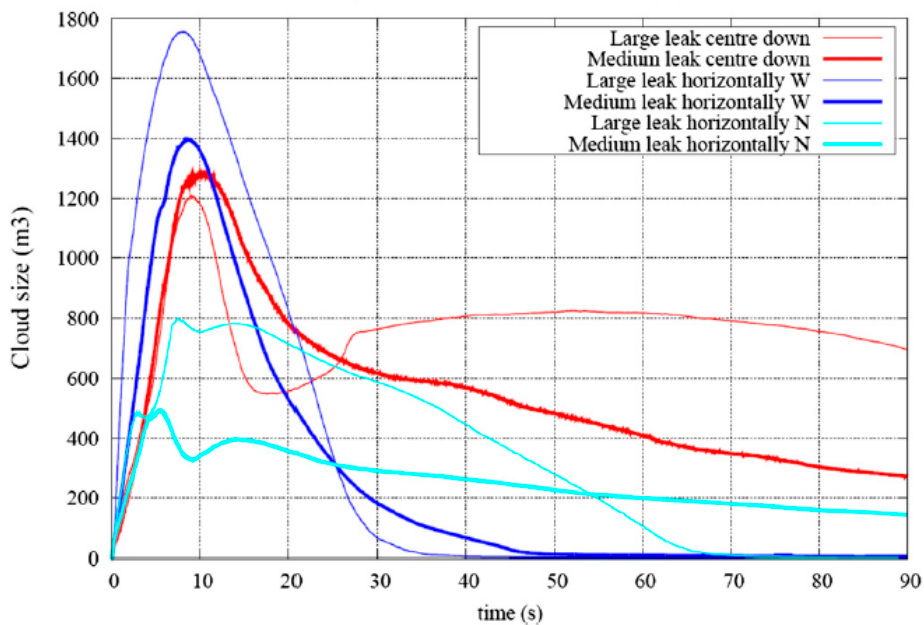
Figure 11. Cloud size vs. time profiles for Q9 clouds (taken from [3]). They show characteristic flammable cloud volume variation with time.